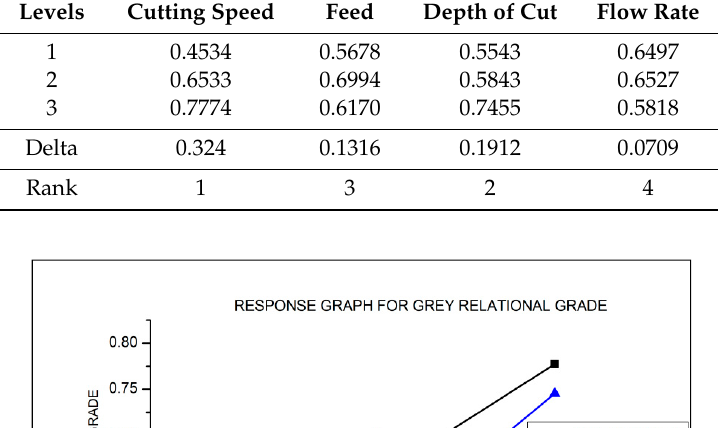
Figure 6. Analysis on Grey Relational Grades.